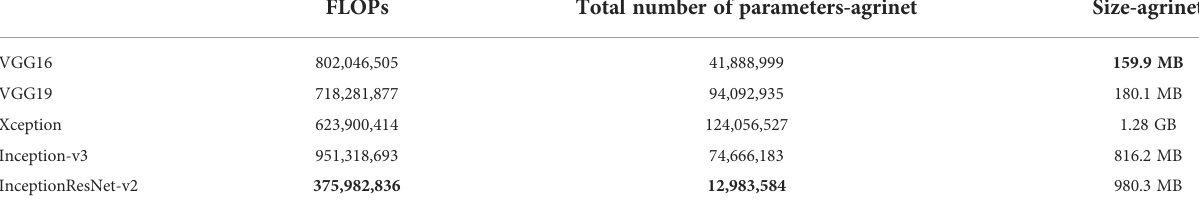
TABLE 5 Comparing imagenet architectures used.